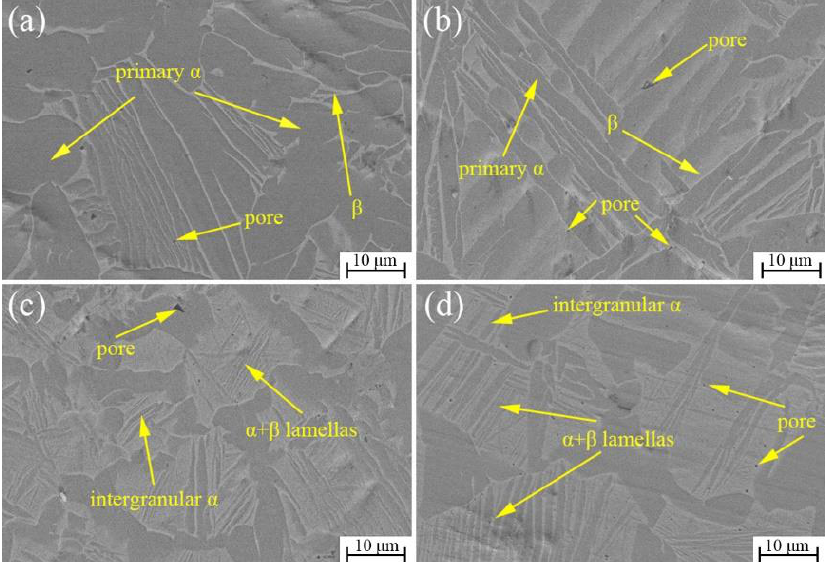
Figure 2. Microstructural images of PM-fabricated Ti-10Nb-xSn alloys: ( a ) Ti-10Nb, ( b ) Ti-10Nb-3Sn, ( c ) Ti-10Nb-5Sn, and ( d ) Ti-10Nb-8Sn.